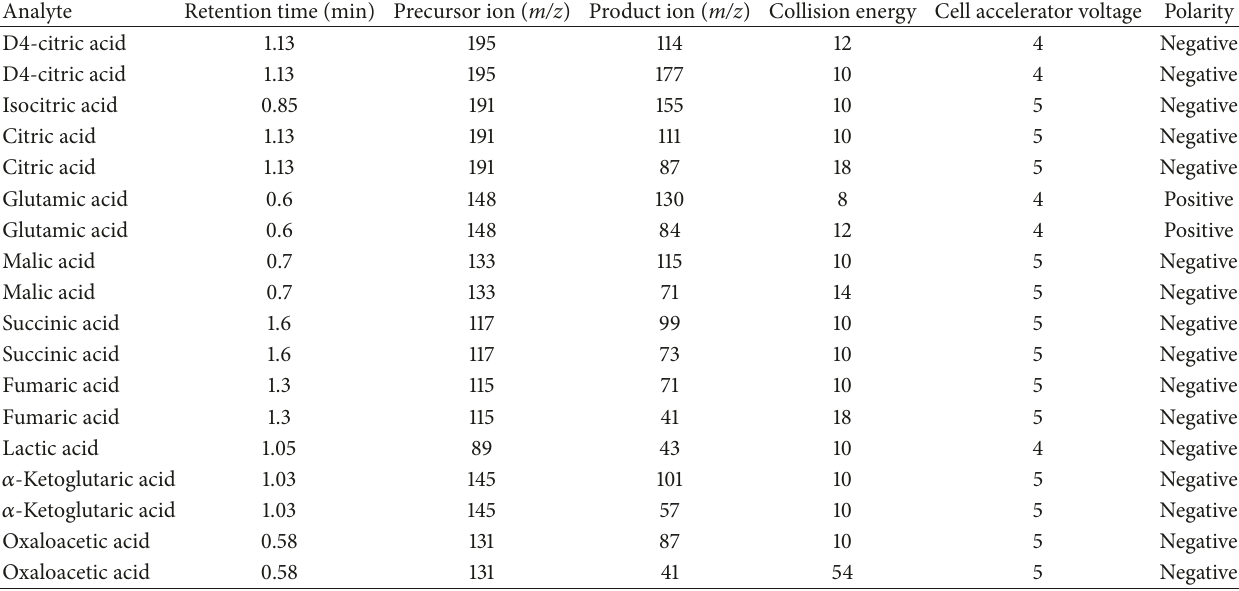
Table 1: LC-MS/MS parameters of each